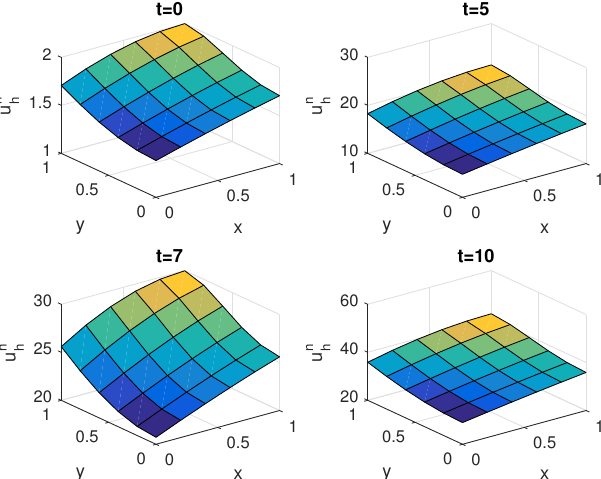
Figure 8. Numerical results of u n Experiment 2.